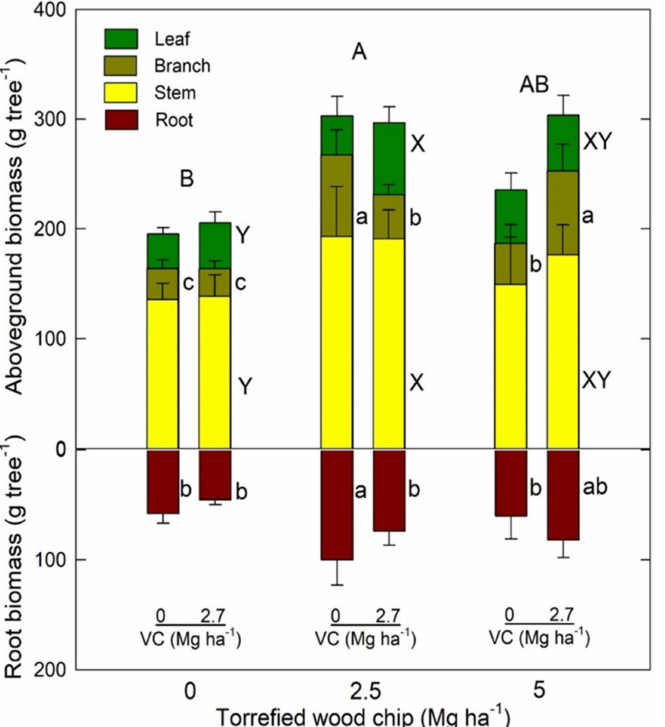
Figure 3. Biomass growth aboveground and belowground of Populus euramericana trees with different amendments of the torrefied wood chips (TWC) and vermicompost (VC). The uppercase letters A, AB, and B indicate significant differences across the TWC treatments for total biomass, and the letters X, XY, and Y indicate significant differences across the TWC treatments for leaf and stem biomass. The different lowercase letters ( a – c ) indicate significant differences across the combinations of TWC and VC treatments for branch and root tissues. The vertical bars indicate standard errors (n =